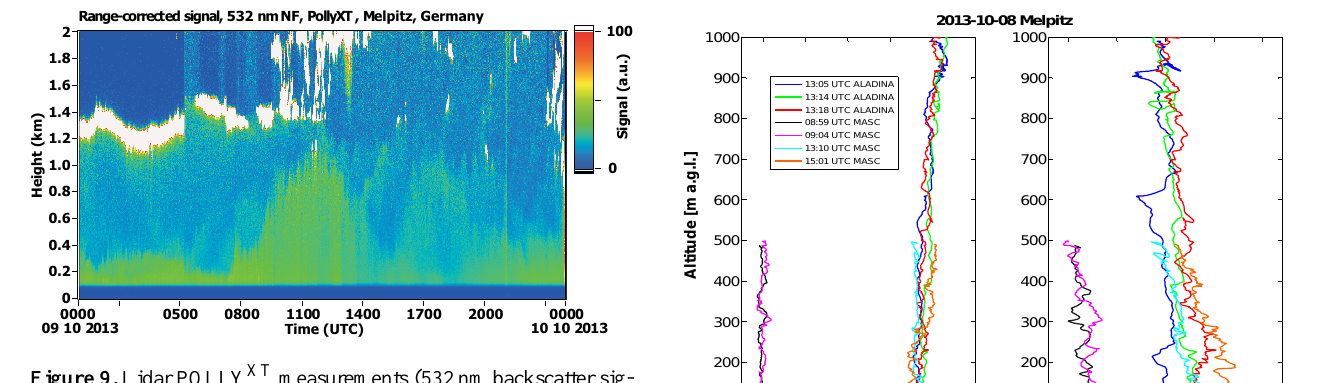
Figure 9. Lidar POLLY XT measurements (532nm backscatter sig- nal) in Melpitz on 9 October 2013.